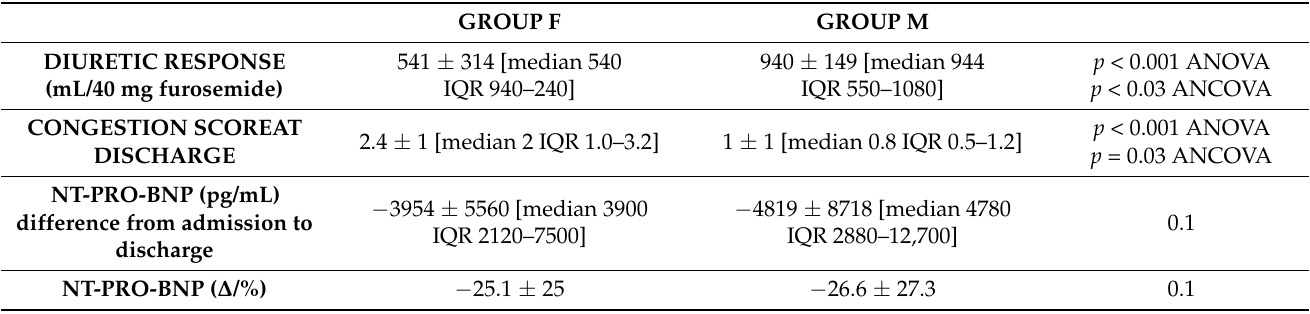
Figure 2. ( A ) Effects of combined metolazone plus furosemide administration (Group M) vs. furosemide alone (Group F) on diuretic response. ( B ) Clinical congestion difference assessed before discharge in Group M vs. Group F. Table 2. Comparison between groups treated with furosemide alone (Group F) and furosemide plus metolazone (Group M) showing a better diuretic response, associated with significant reduction in congestion in group treated with combined diuretics.